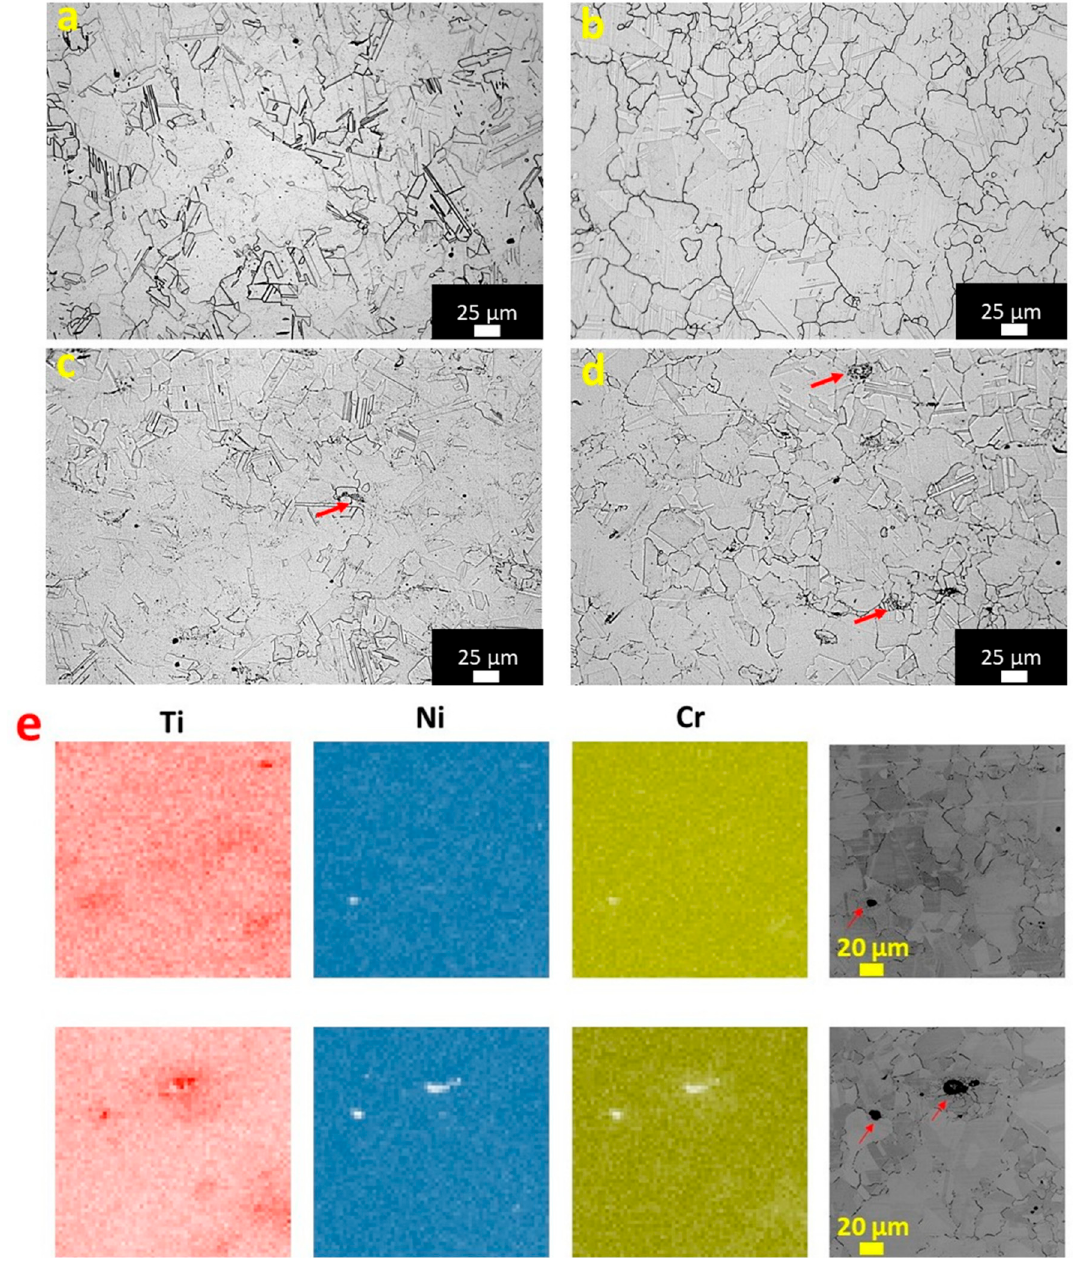
Figure 5. LOM images of the ST IN625 ( a ), STA IN625 ( b ), ST IN625mod ( c ), and STA IN625mod ( d ). Presence of residual Ti segregations (pointed by the red arrows). EDS maps of the STA IN625mod ( e ) showing the zones with Ti segregations with near-circular shape.